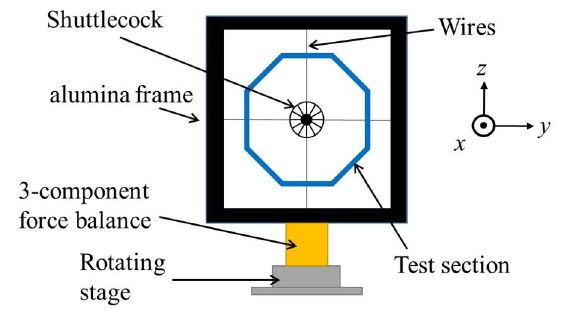
Figure 1. Bottom view of the experimental